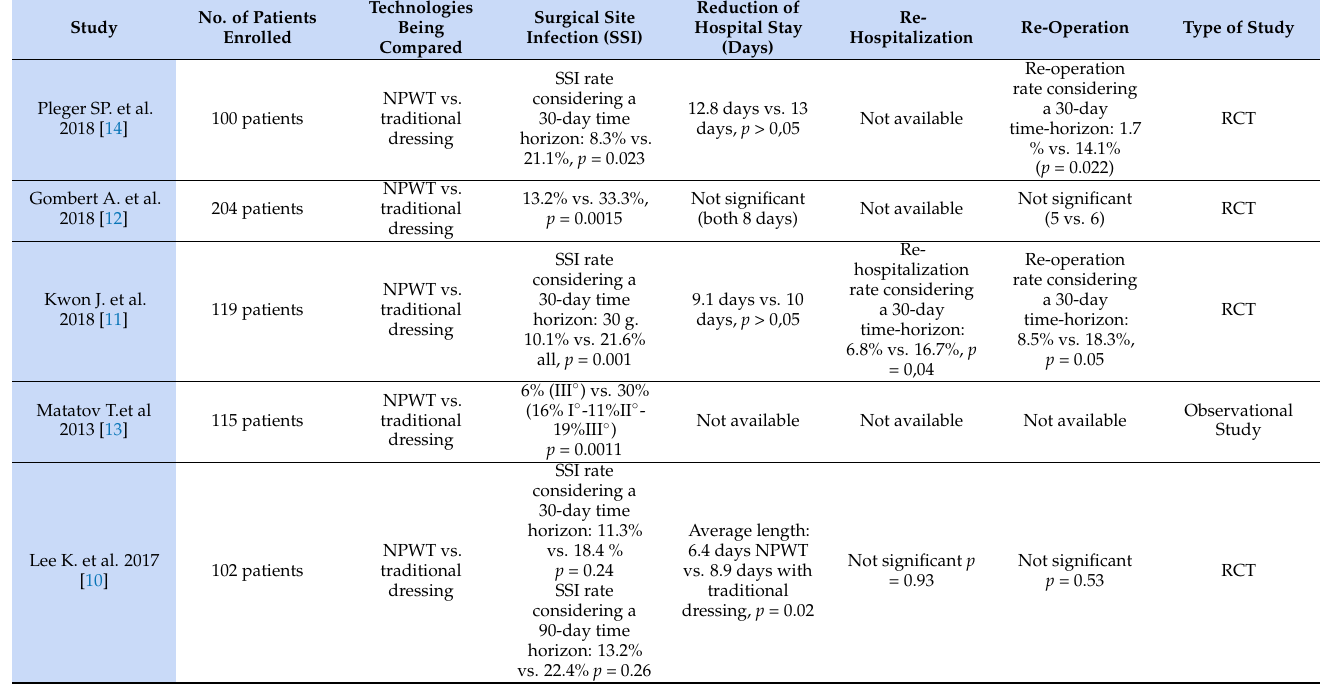
Table 1. Endpoints from the literature.